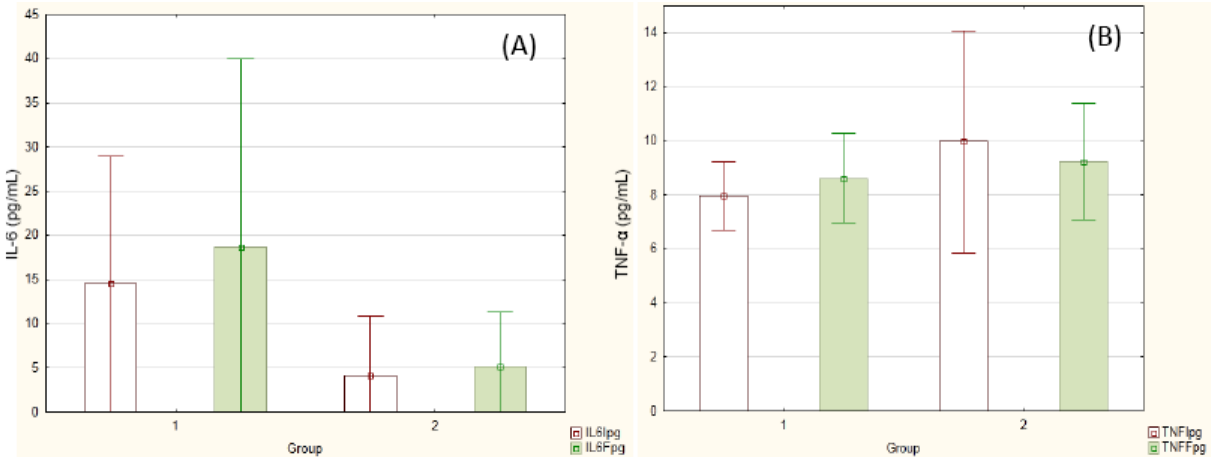
Figure 1. Cytokine concentration before (white columns) and after (green columns) supplementation. ( A ) IL-6; ( B ) TNF-α. Group 1 = PLA ( n = 8); Group 2 = SYN ( n = 9). Repeated measures